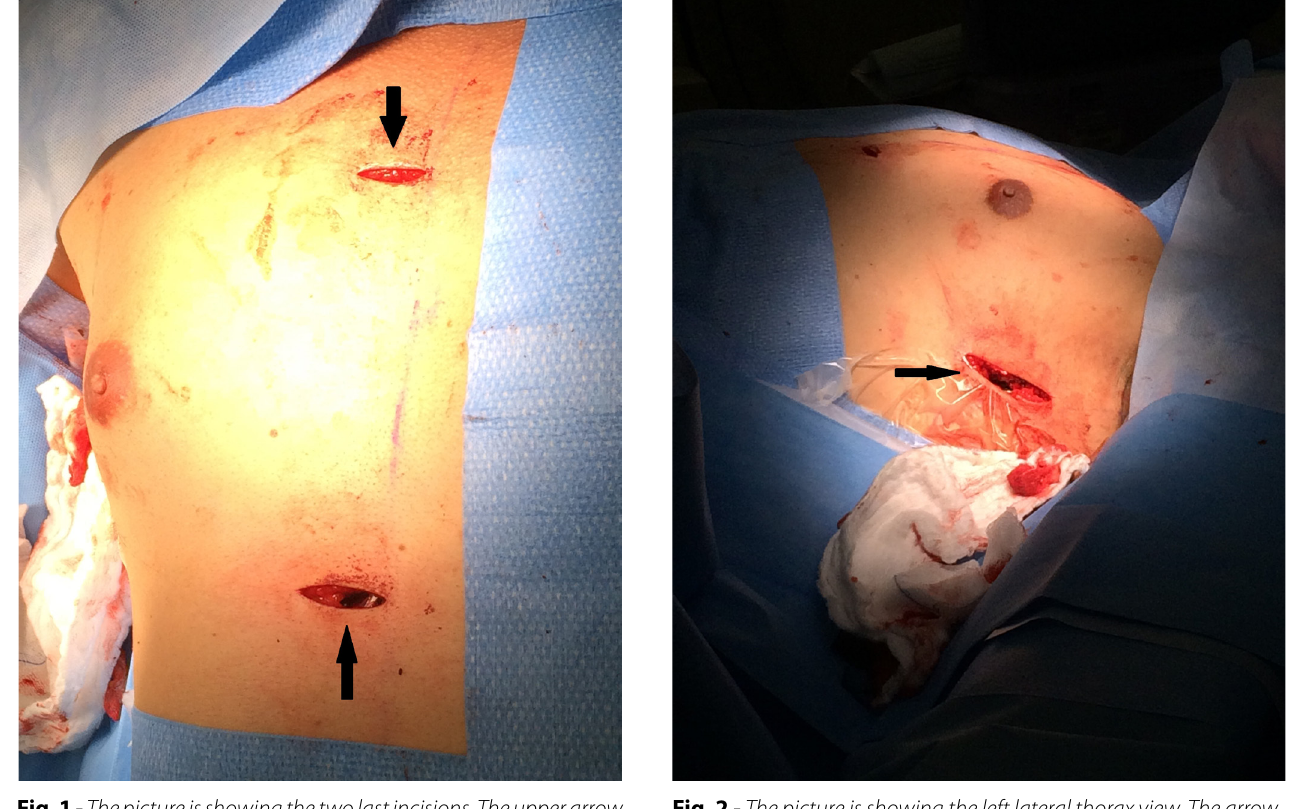
Fig. 1 - The picture is showing the two last incisions. The upper arrow in pointing out the last incision and the lower arrow is pointing out the second incision.